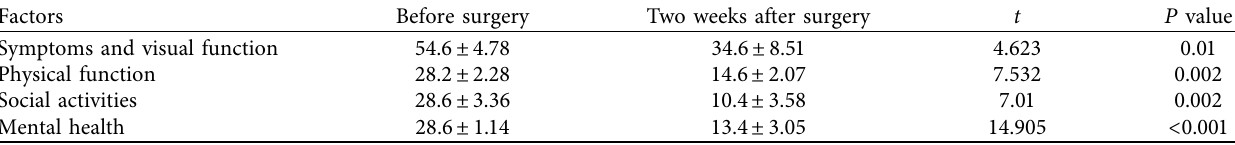
Table 1: Comparison of SQOL-DVI scores before and after surgery in patients with Graves ophthalmopathy. Factors Before surgery